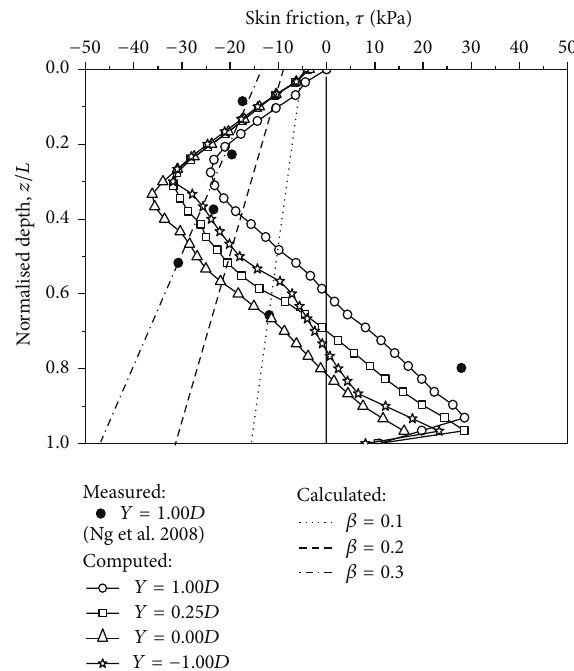
Figure 5: Measured and computed skin friction distribution due to a surcharge